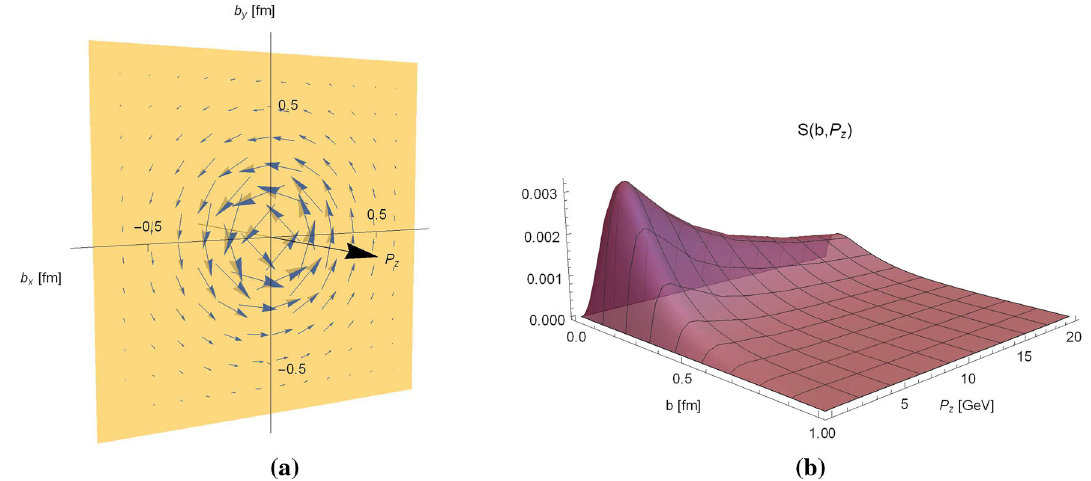
P z = 0 . 1 GeV, and b magnitude of the quark spin density S as a function of the impact-parameter b and the target momentum P